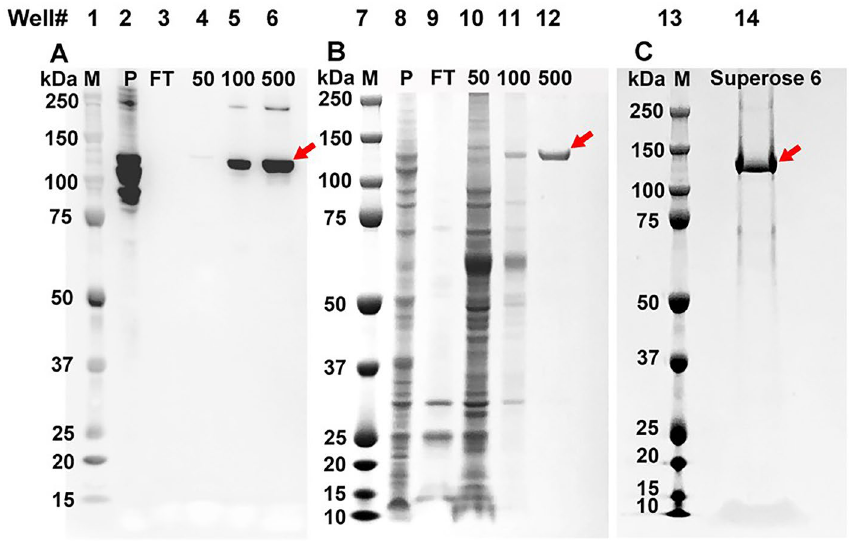
Figure 3. Purification of full-length pGC-A via affinity and size exclusion columns. ( A ) Western blot (anti- pGC-A) of samples from cell lysis to the affinity column. pGC-A (red arrow) is ~ 120 kDa. ( B ) Coomassie blue stain from cell lysis to the affinity column. ( C ) Coomassie blue stain of the eluted fraction from Superose 6 that was used for protein crystallization. M: marker; P: membrane pellet from ultracentrifugation after solubilization with n-dodecyl-β-D-maltoside (DDM) and cholesteryl hemisuccinate (CHS); FT: flowthrough from the affinity column; 50, 100, 500: imidazole (mM) at elution from the affinity